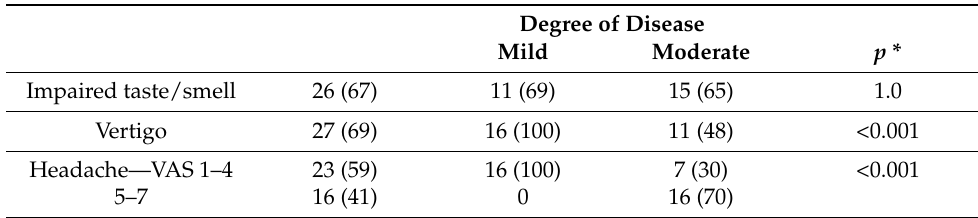
Table 5. Display of the number (%) of subjects according to symptoms in relation to the severity of the disease.